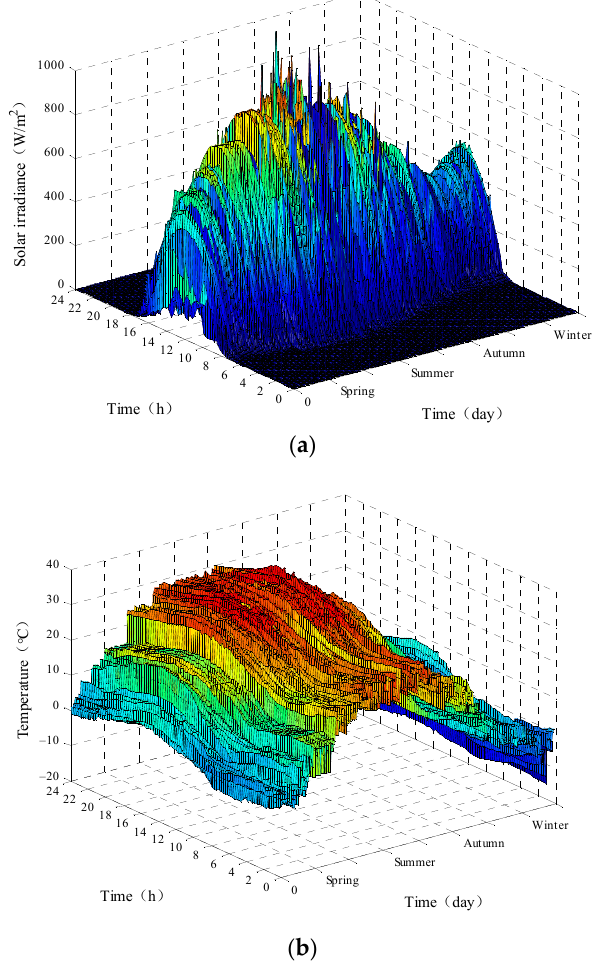
Figure 2. Nonlinear characteristic of external input. ( a ) Annual solar irradiance time series of 2016; ( b ) Annual temperature time series of 2016.